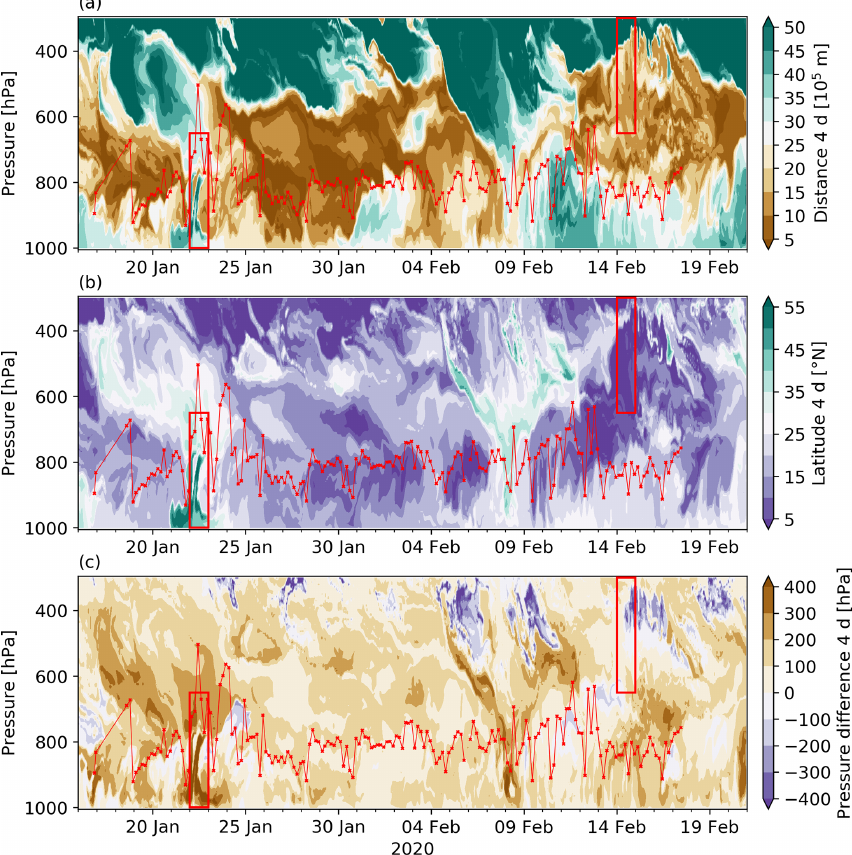
Figure 4. Time series of vertical profiles from ERA5 of the transport conditions at the BCO during EUREC 4 A and height of the lowest temperature inversion (of at least 0.4 ◦ C over the depth of the inversion) derived from the BCO soundings (red lines with dots). Shown are the air parcel’s (a) great-circle distance from the arrival location traveled in the 4d prior to arrival, (b) latitudinal position 4d prior to arrival, and (c) pressure change along the trajectory during the 4d prior to arrival (positive/negative values indicating descent/ascent towards the arrival location). A Gaussian filter was applied to all variables for better readability. Again, the red boxes highlight the layers and periods of the two case studies. The time axis is given in UTC (Barbados local time: UTC − 4h). Table 1. Size and humidity of the five airstreams arriving above the BCO in the layer 1000–650hPa on 22 January 2020. Data: ERA5. Number of trajectories Mean specific humidity Contribution